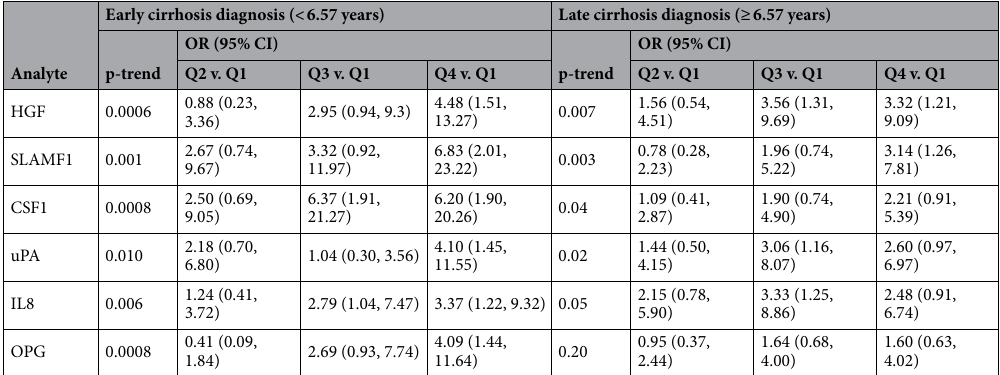
Table 4. REVEAL-HBV odds ratios* and 95% CIs stratified by time to cirrhosis diagnosis. *Adjusted for age, sex, years of follow up, HBV viral load, serum alanine aminotransferase (ALT) level, alcohol, smoking, and HBV e antigen